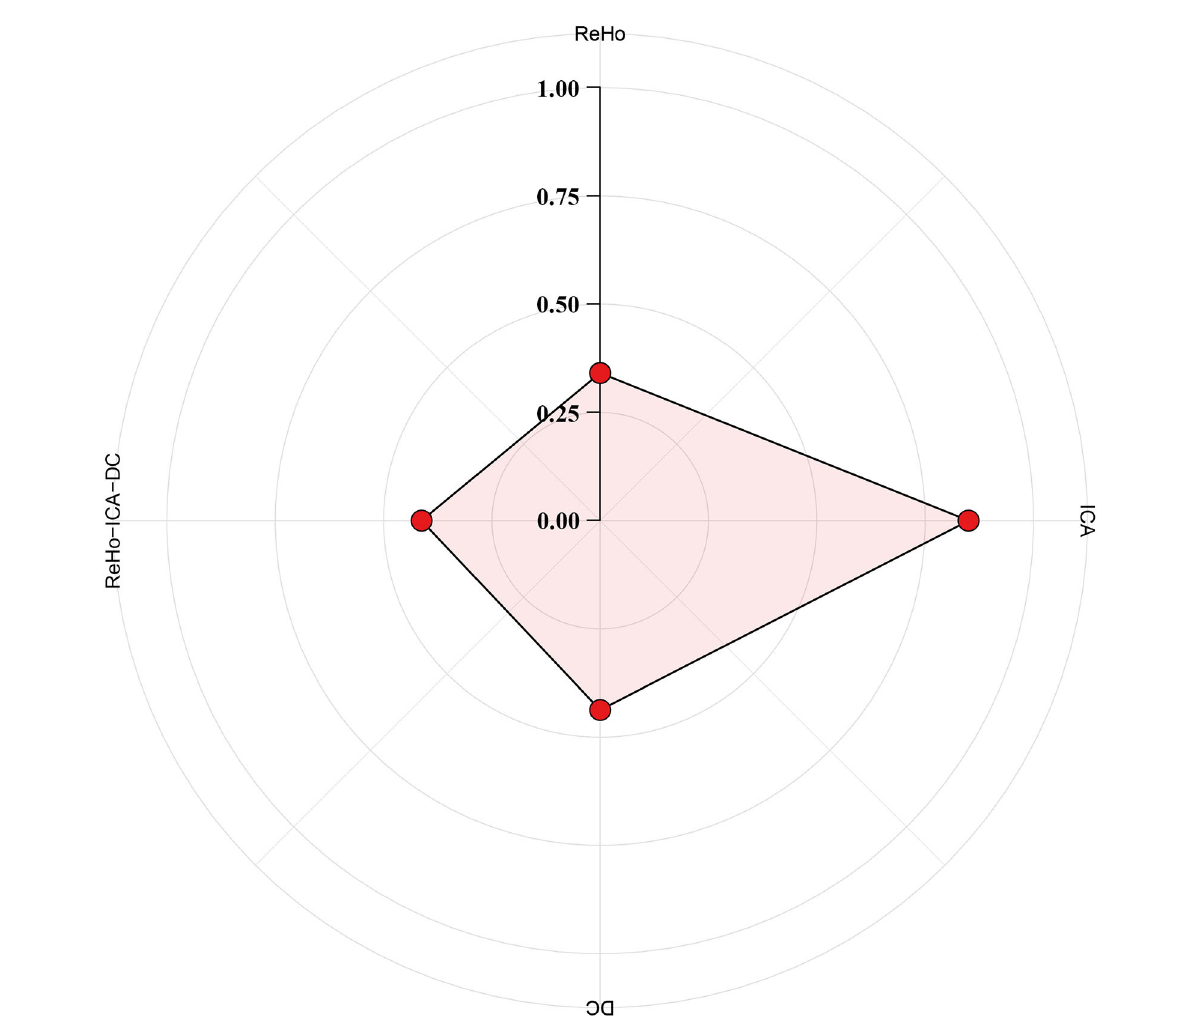
FIGURE5 Indicator of reliable brain function. The test–retest reliability was measured with intra-class correlation (ICC) for the following brain functional indicator: regional homogeneity (ReHo), independent component analysis (ICA), degree centrality (DC), and ReHo, ICA, and DC combined. A metric with moderate to almost perfect test–retest reliability (ICC